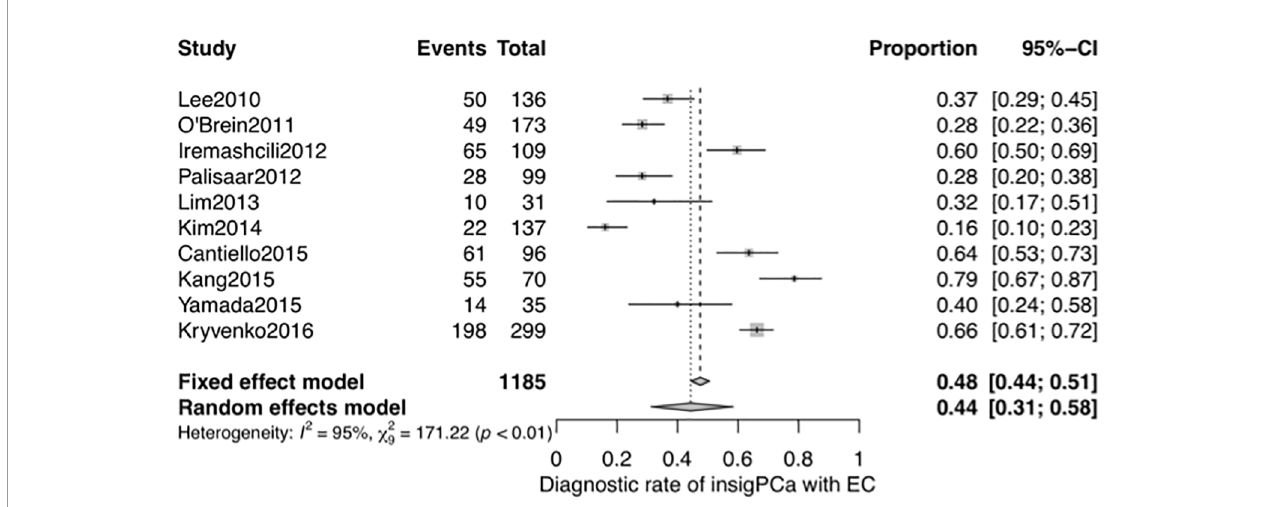
FIGURE 5 | Forest plot of studies that explored the diagnostic accuracy of the EC for